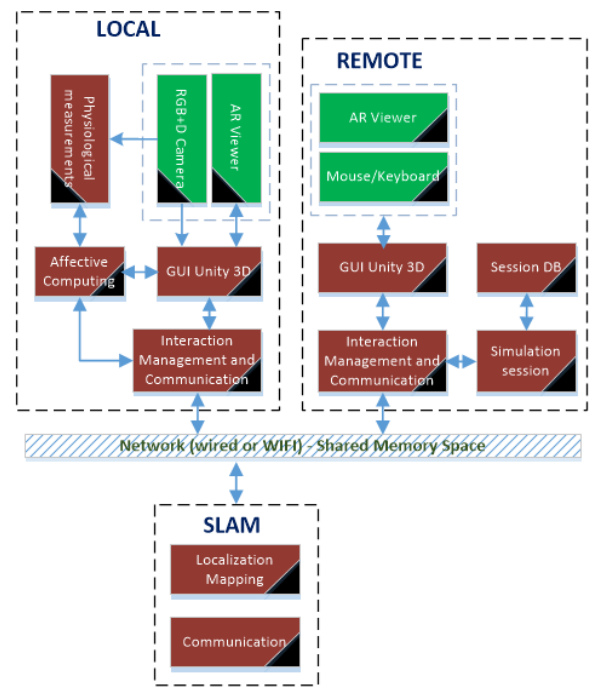
Figure 6. AWARE framework for adaptive AR train-